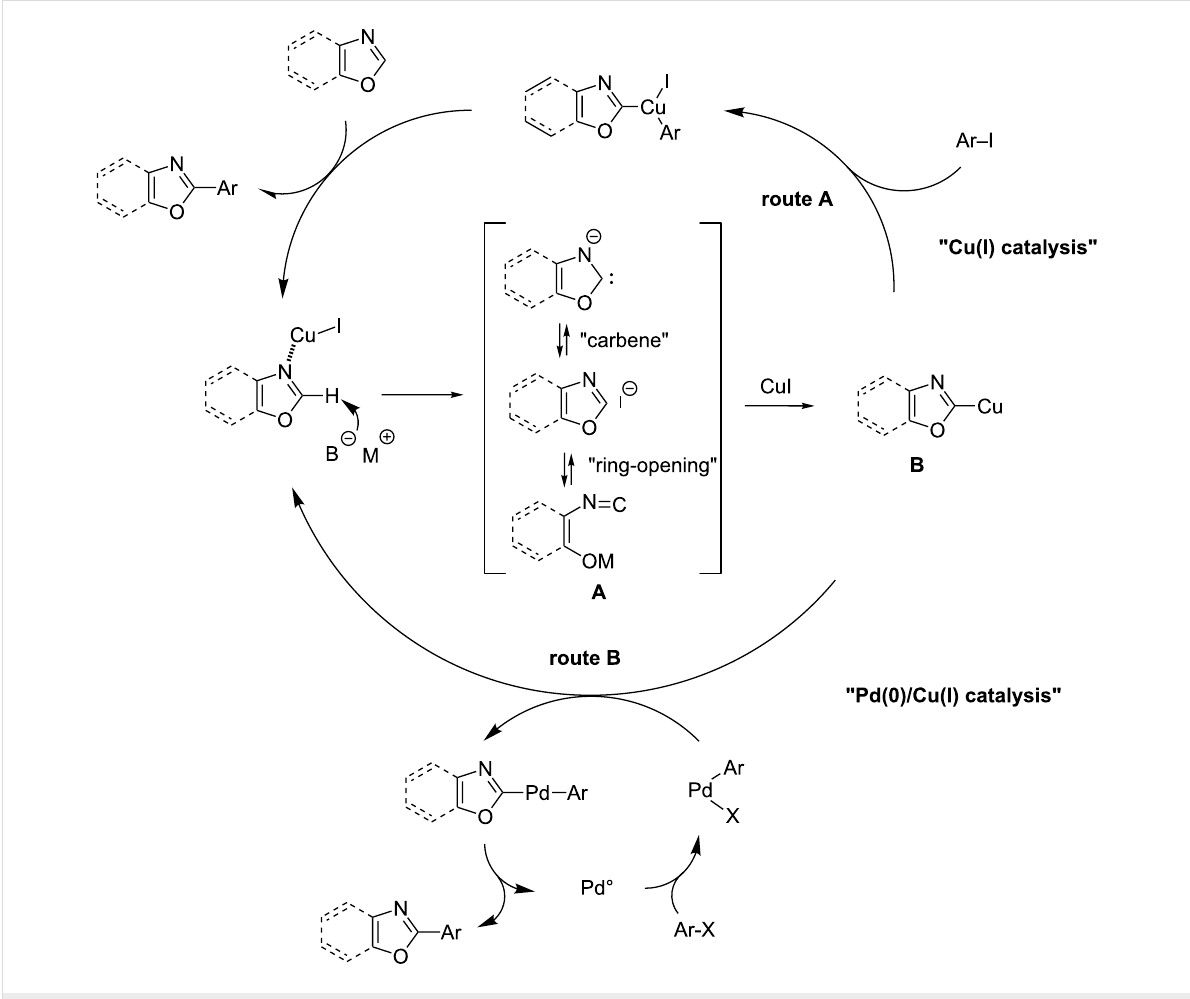
Scheme 18: Catalytic cycles for Cu(I)-catalyzed (routeA) and Pd(0)/Cu(I)-catalyzed (route B) direct arylation of oxazoles with halides proposed by Bellina and Rossi [67].